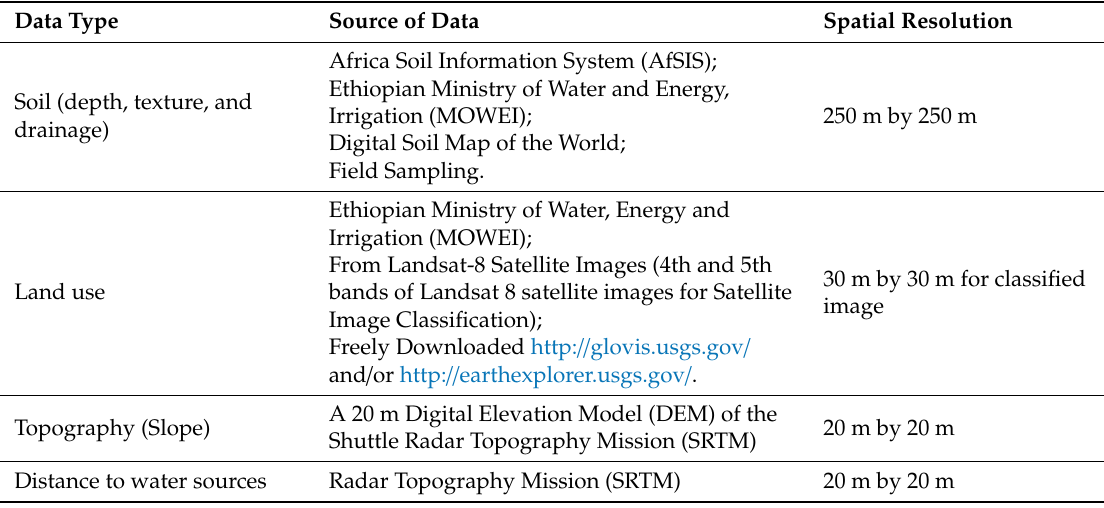
Table 1. Summary of the data sources and factors for the land suitability